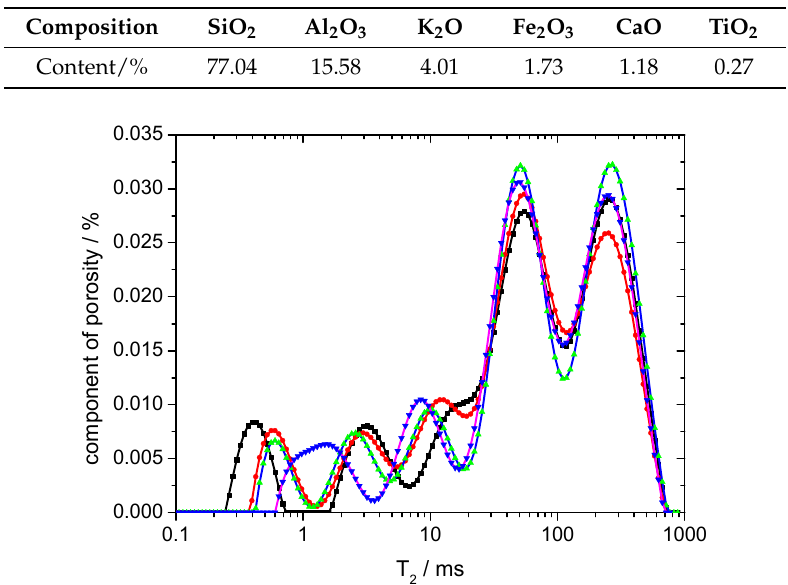
Table 1. The mineral composition of the granite used in this study.